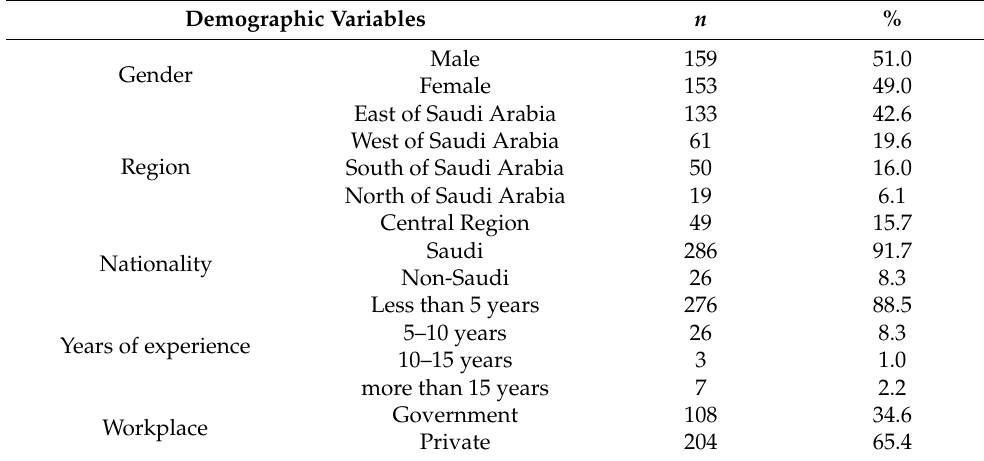
Table 1. Demographic details of study participants ( n =